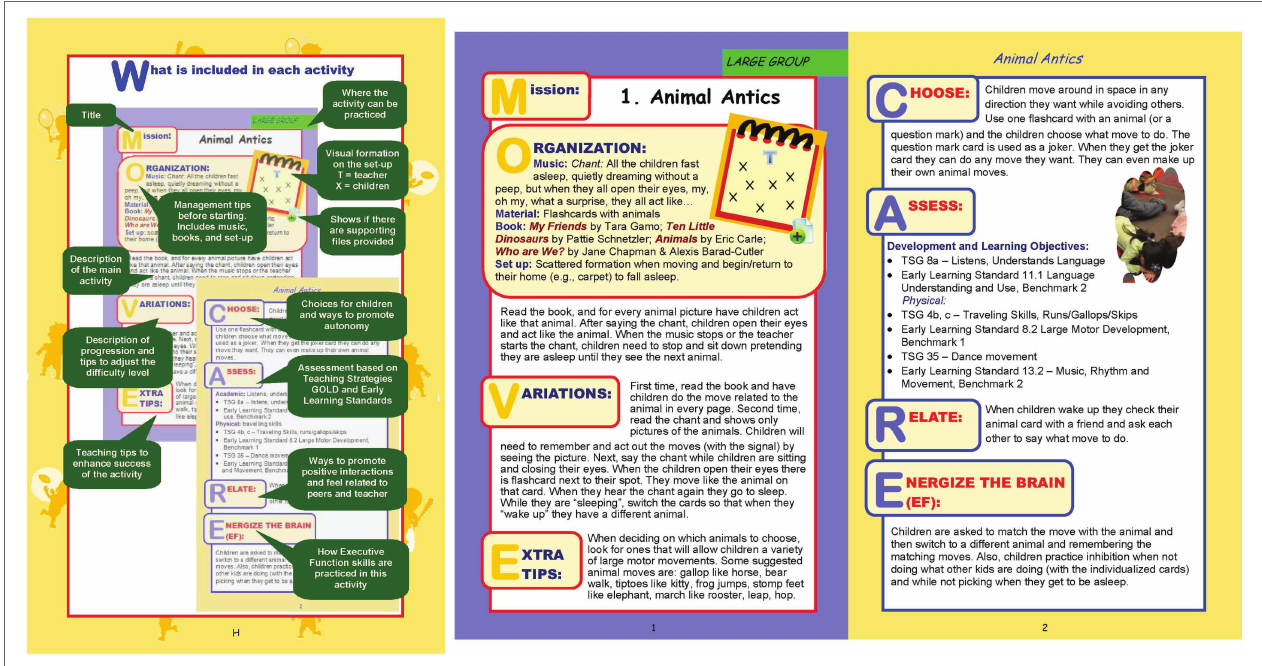
FIGURE 2 | Example of “Move for Thought” preK-K